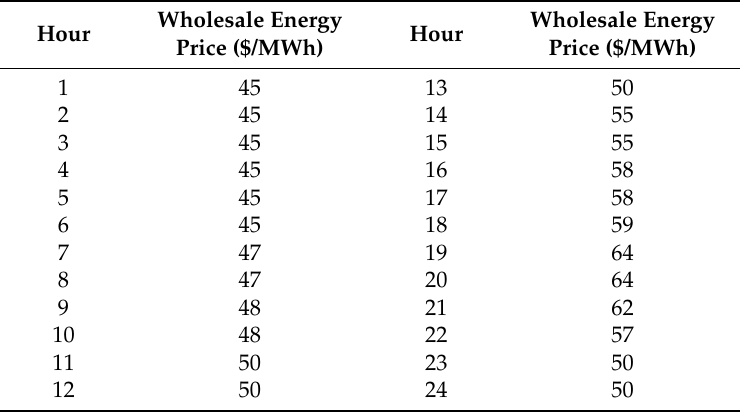
Table 3. Reactive power offer prices of the DG units.